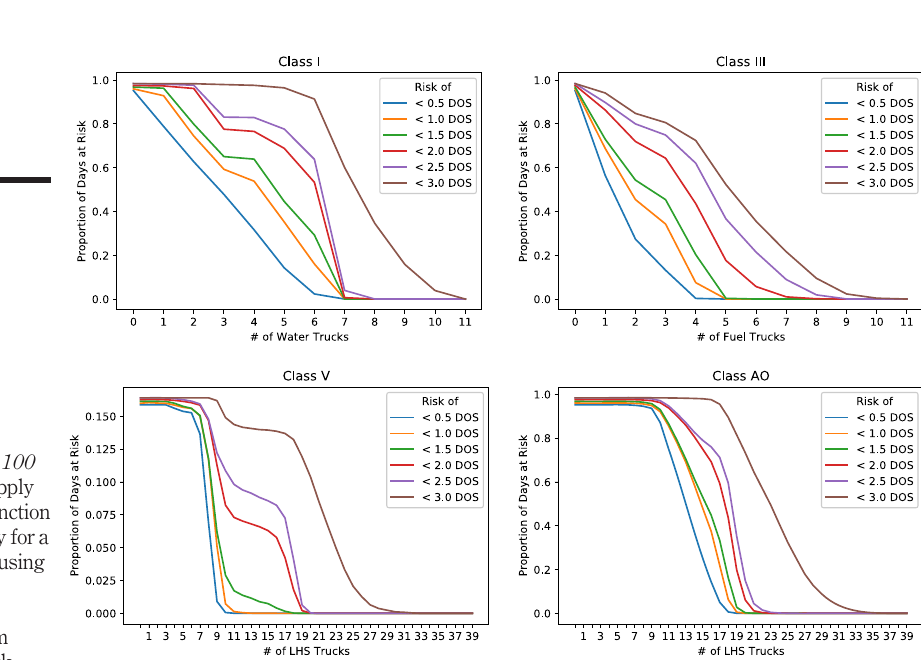
Figure A1. Simulation with 100 Runs: risk of supply shortage as a function of truck capacity for a 63-day con fl ict, using triangular distributions to generate random samples for truck availability and